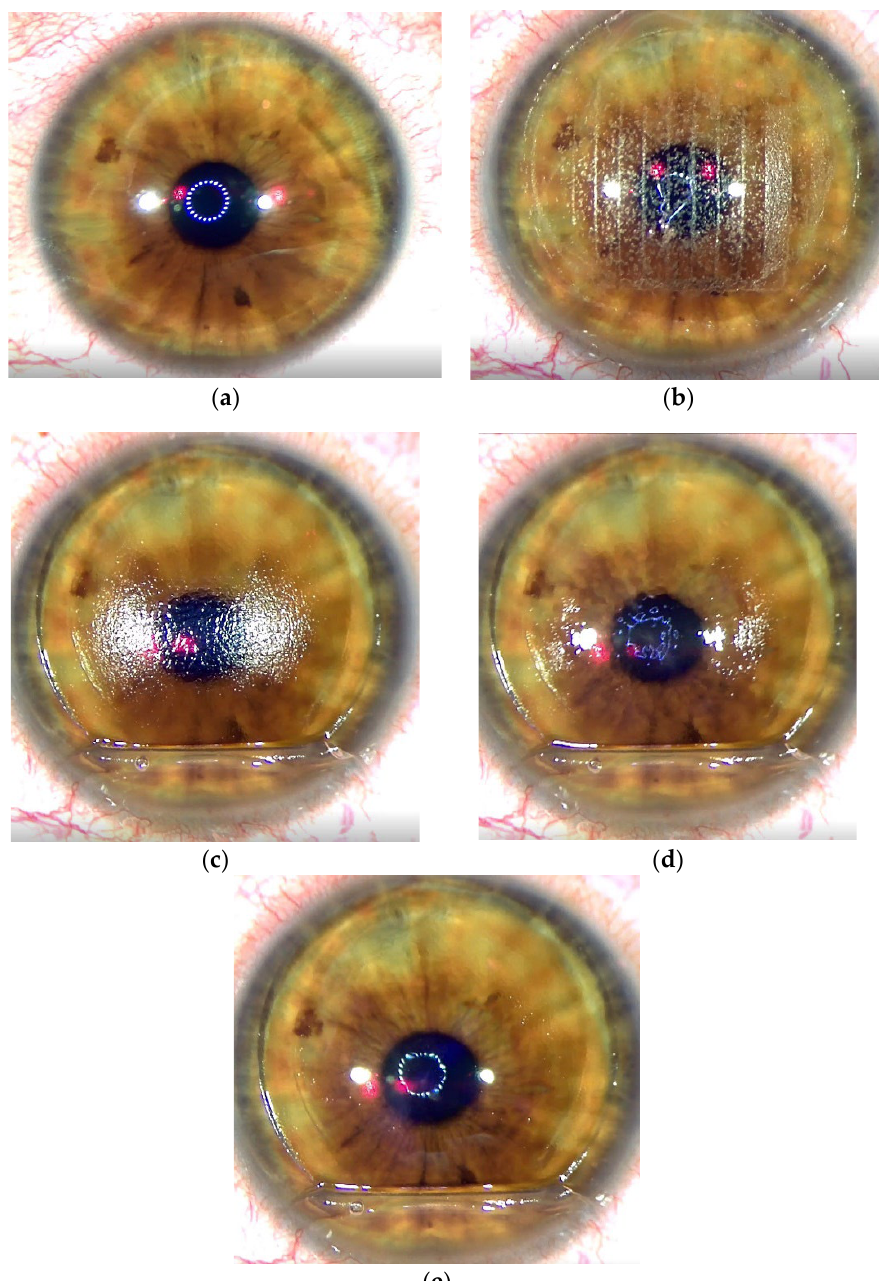
Figure 3. ( a ) Eye condition before treatment, ( b ) situation after femtosecond laser incision, ( c ) dry stroma bed before laser application, ( d ) fluid builds up on the stroma during laser treatment, ( e ) stroma bed covered with fluid after treatment.